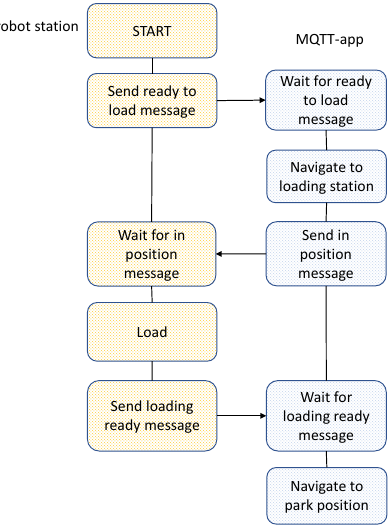
Figure 8. Mobile robot MQTT-app